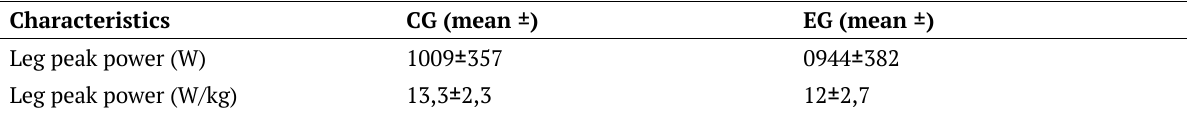
Table 2. Characteristics of anaerobic power and capacity of students’ wrestlers participated for the experimental group ‘’EG’’ and control group ‘’CG’’ (n = 20) Characteristics